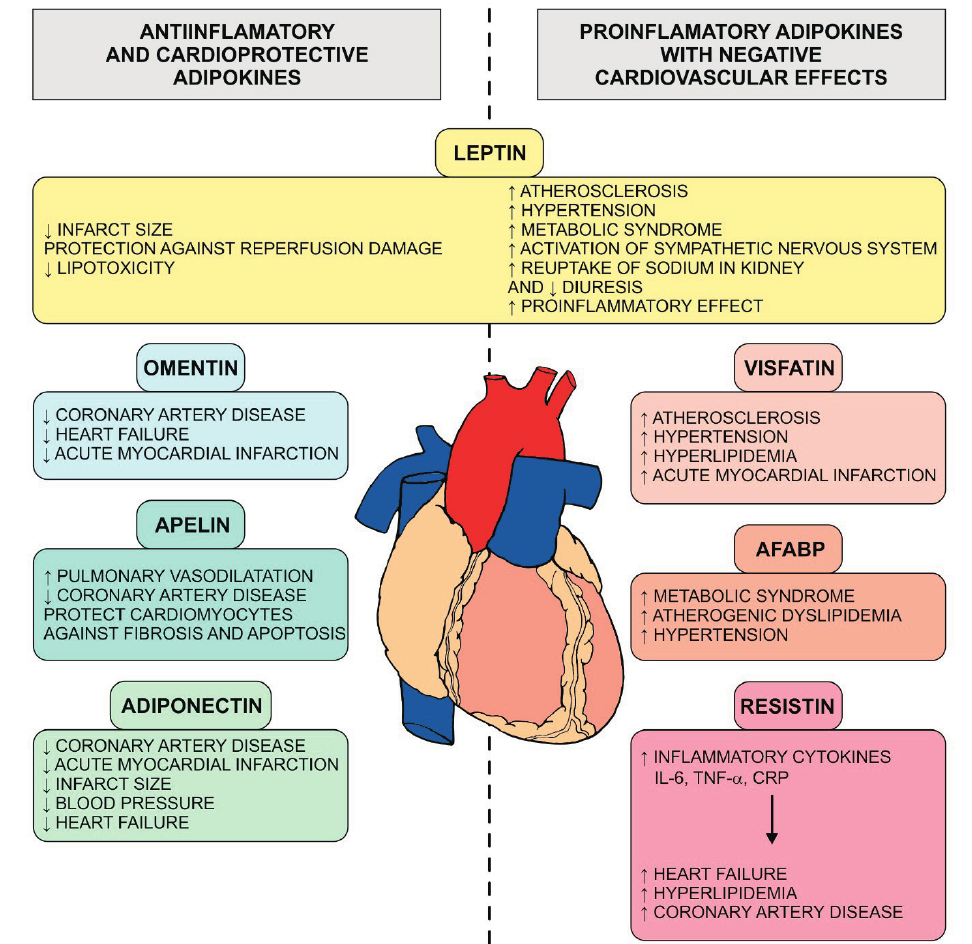
Fig. 2. Overview of positive and negative cardiovascular effects of major